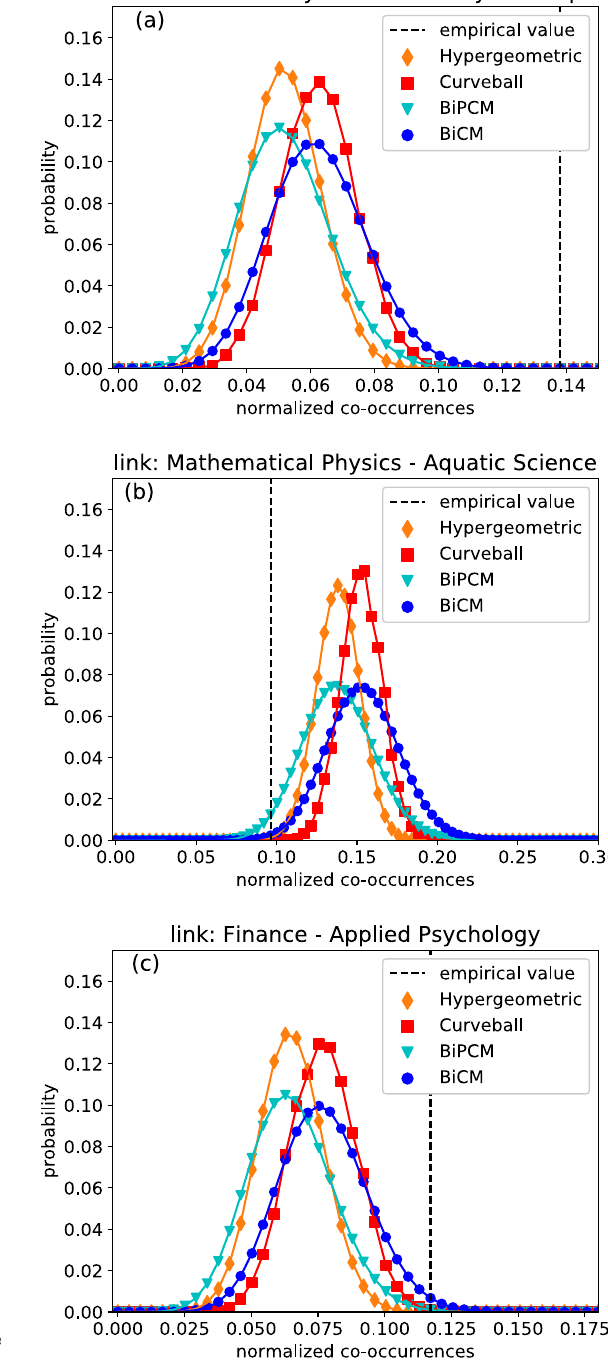
Fig. 2 Comparison of empirical co-occurrences and their null model distributions for representative scienti fi c fi eld pairs. a Mathematical Physics - Geometry and Topology , b Mathematical Physics - Aquatic Science , c Finance - Applied Psychology . For each pair ( i , j ) of scienti fi c fi elds we report the empirical value of the (normalized) co- occurrences C ij / ∣ Γ ∣ and the respective null model distributions π ( ⋅ ∣ i , j ). The p -value is given by the area under the distribution starting from the empirical value, hence the outcome of the validation procedure strongly depends both on the signi fi cance threshold p * and the choice of the null